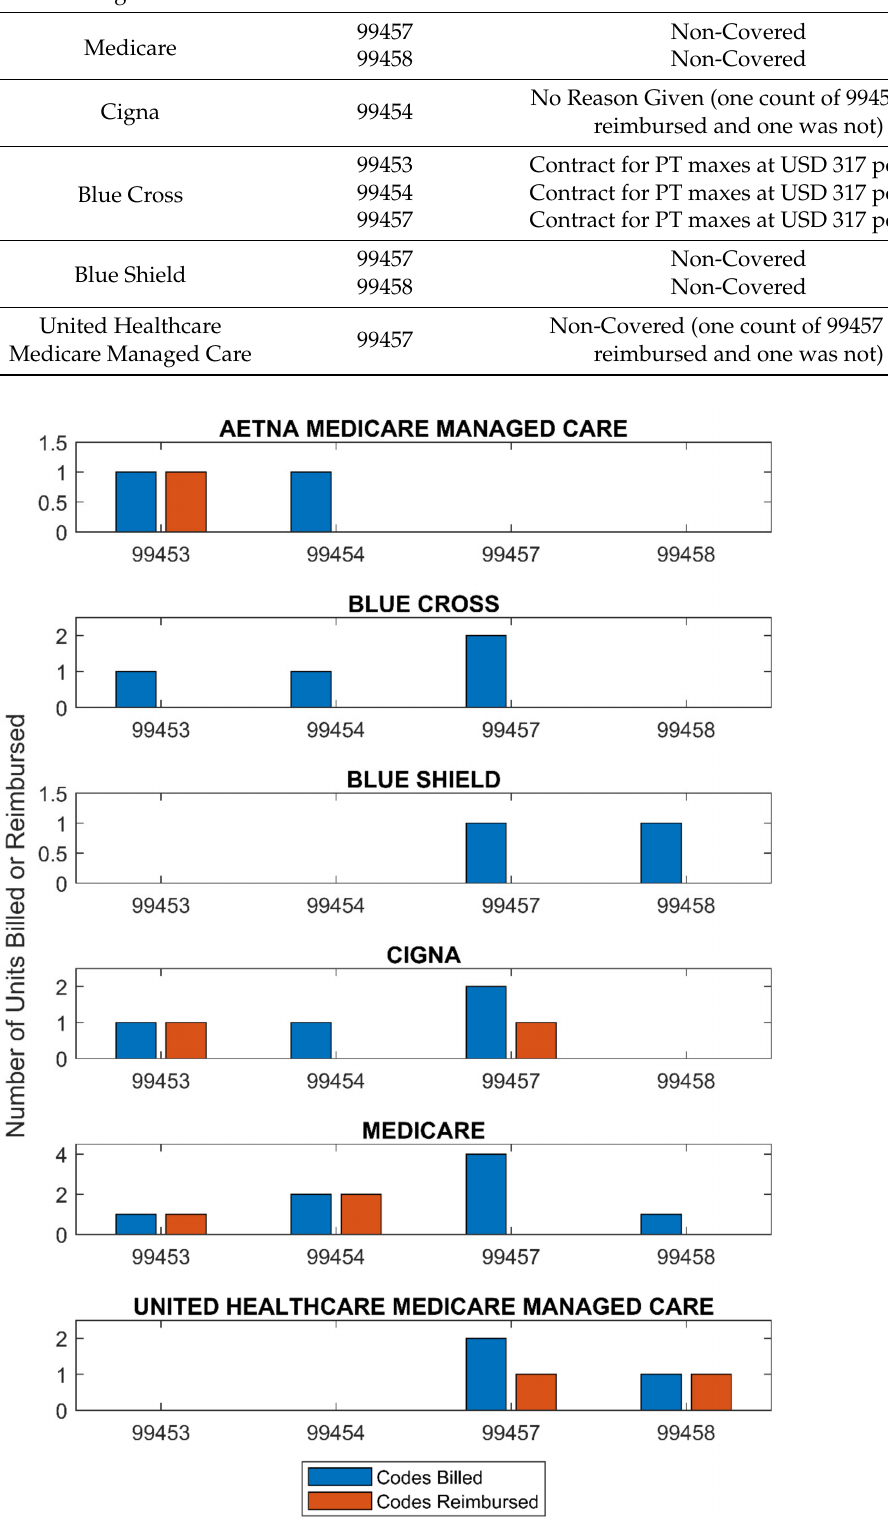
Figure 2. Chart of codes billed (blue) and codes reimbursed (orange) organized by